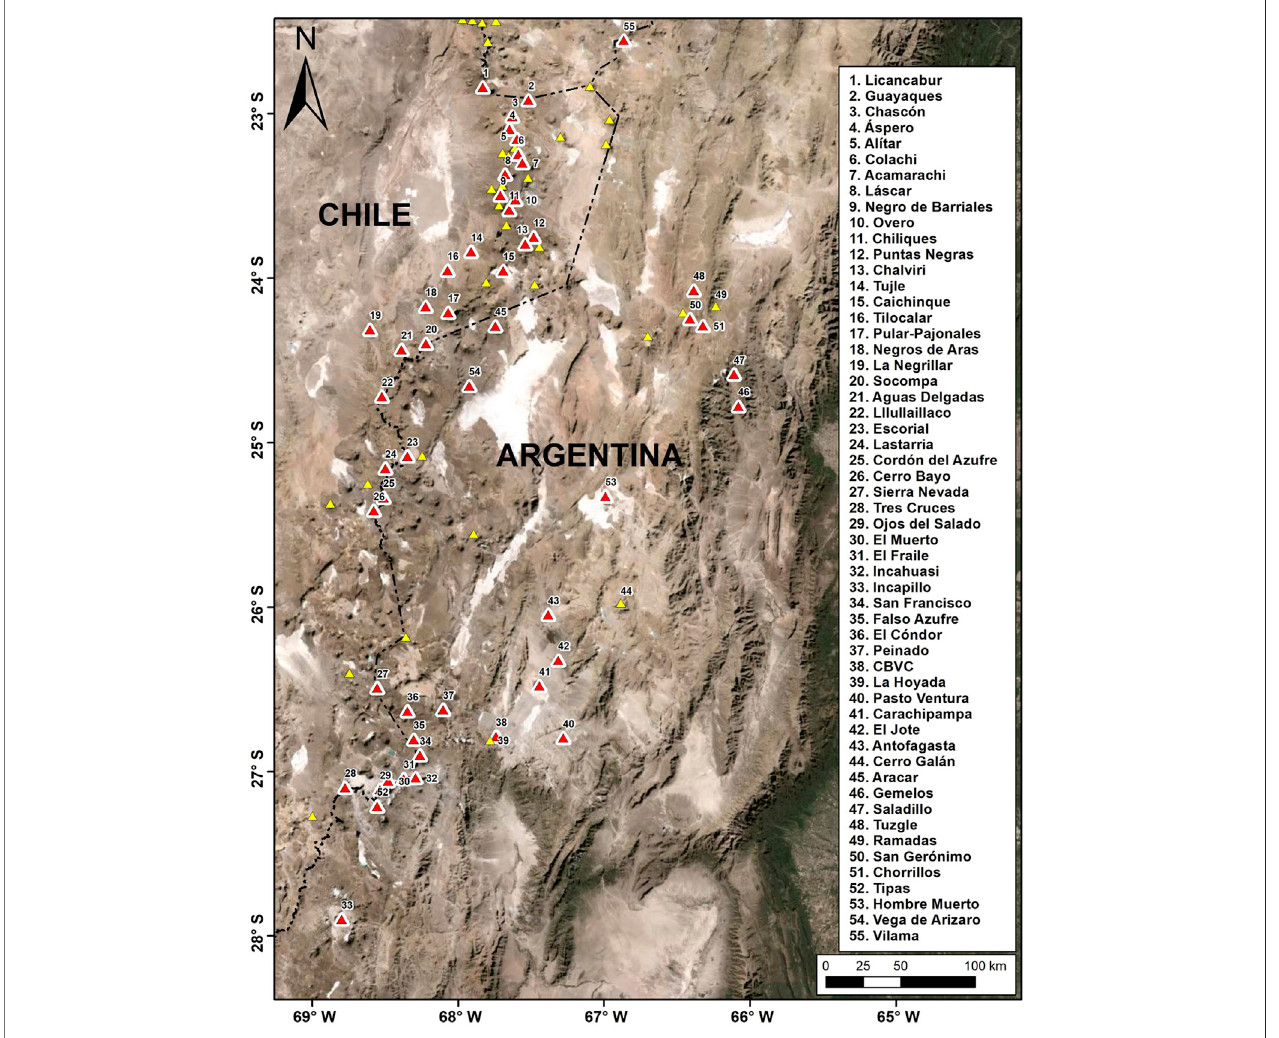
FIGURE 2 | The Central Volcanic Zone of the Andes of Chile and Argentina (~22.5 – 28 ° S). Yellow and red triangles correspond to the Plio-Pleistocene and Pleistocene-Holocene volcanoes in the region, respectively, modi fi ed from Siebert et al. (2010). Minor monogenetic fi elds/centres have been included as well. All the volcanoes of interest are labelled. CBVC = Cerro Blanco volcanic